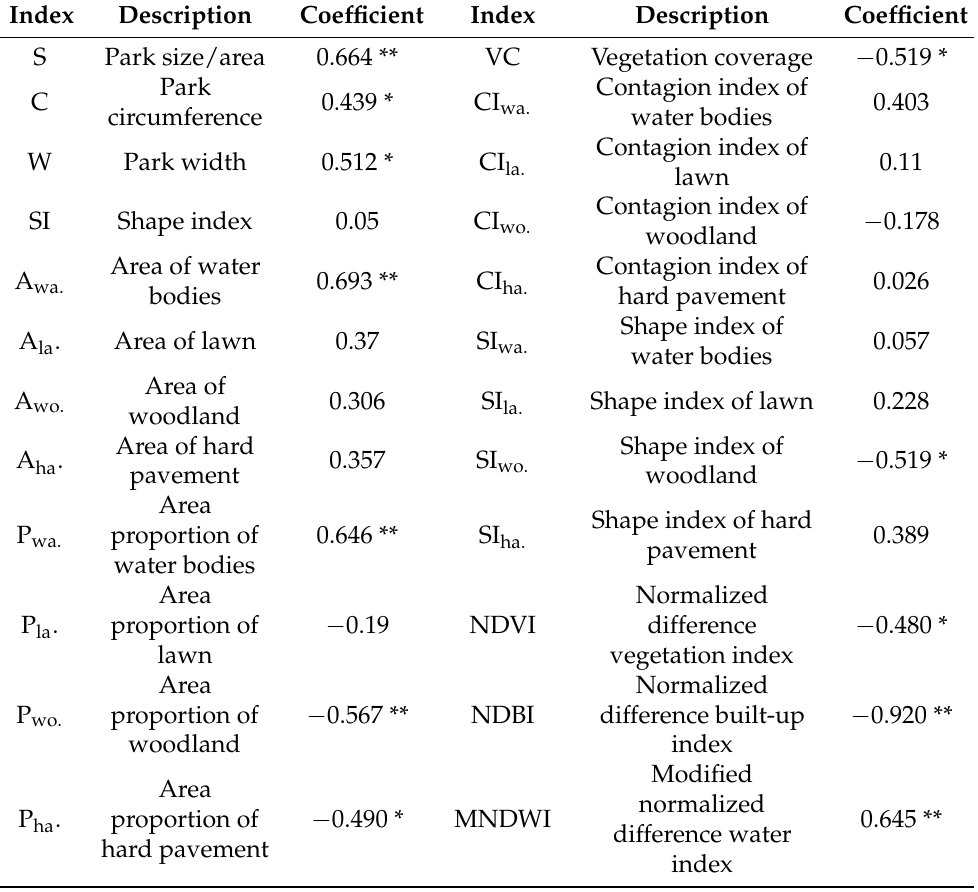
Table 3. Correlation coefficients between PCI and park structure characteristics ( n =27).